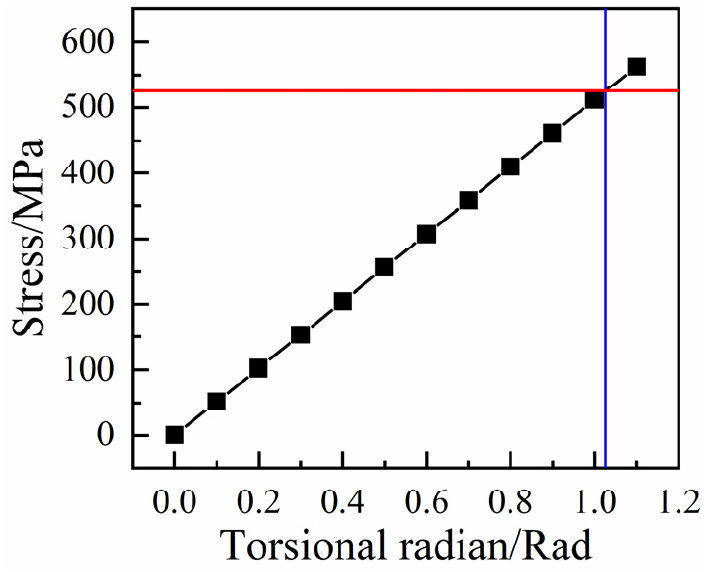
Figure 13. Curve of fiber stress with increasing torsional radians.